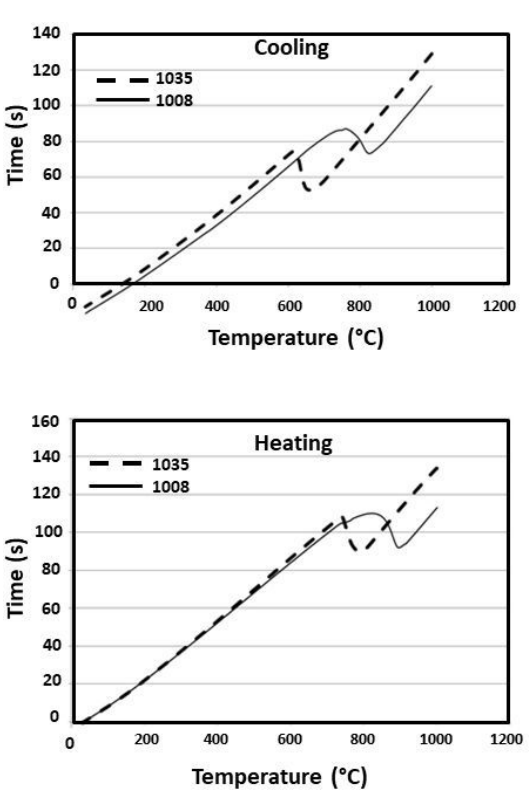
Figure 2. Heating and cooling curves obtained by